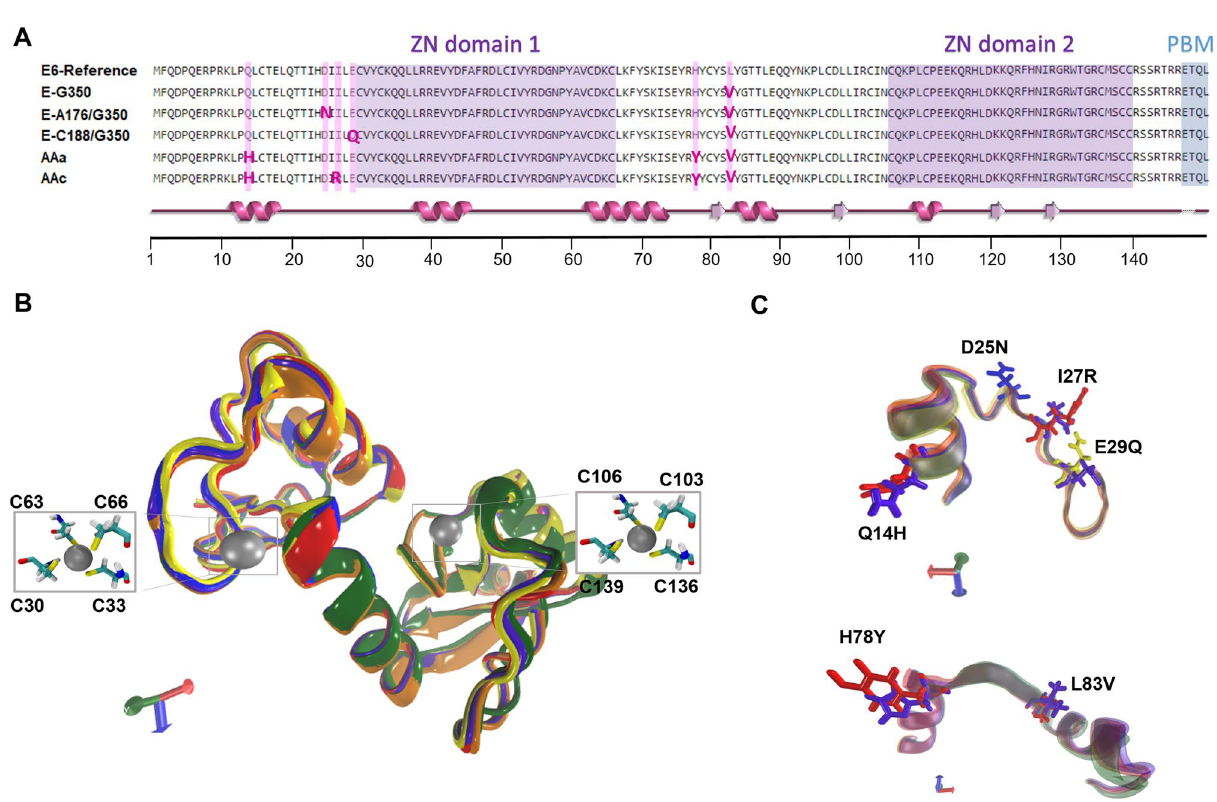
Figure 1. Alingment and super position of the 3D structures of the E6-reference and its variants. ( A ) Multiple alignment of the sequence of E6 and its variants. Zinc finger domain 1 and 2 are highlighted in purple, PBM in blue and mutations are highlighted in pink. A super position of the secondary structure of all six proteins is shown in pink below the alignment. ( B ) 3D structure of E6-reference: violet, AAa variant: orange, AAc variant: red, E-G350, green, E-C188/G350: yellow, E-A176/G350: blue. The silver spheres indicate zinc molecules and the licorice residues correspond to C30, C33, C63, C66, C103, C106, C136 and C139, which make up two zinc finger domains in the proteins 3D structures. The orientation of the proteins is indicated by the axes, X: red, Y: green; Z: blue. ( C ) Visualization of amino acid changes: Q14H, D25N, I27R, H78Y and L83V are in